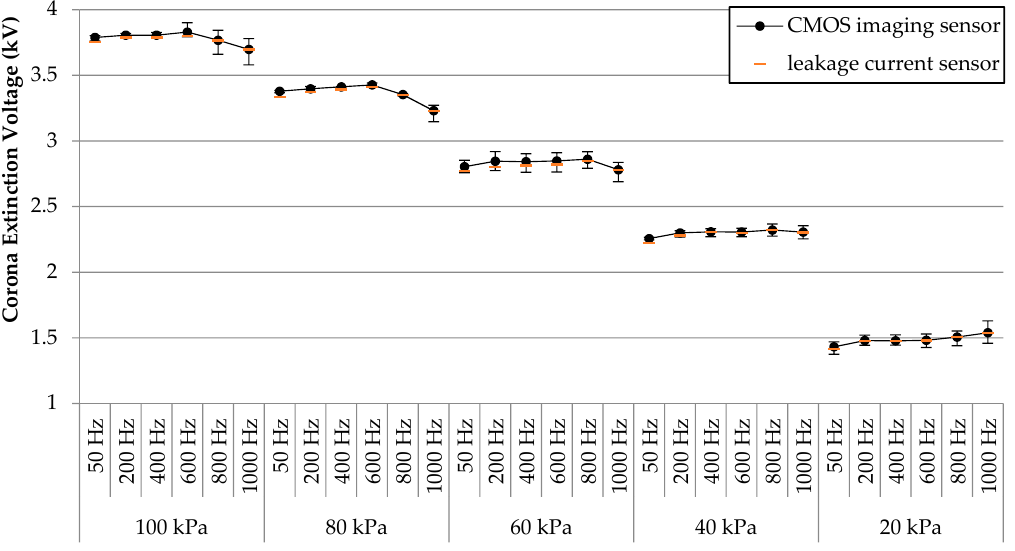
Figure 4. Experimental results of the rod-to-plane electrode geometry. CEV values (kV) versus pressure (kPa) and supply frequency (Hz). Results from the imaging sensor and the leakage current sensor (resistor) were plotted together.